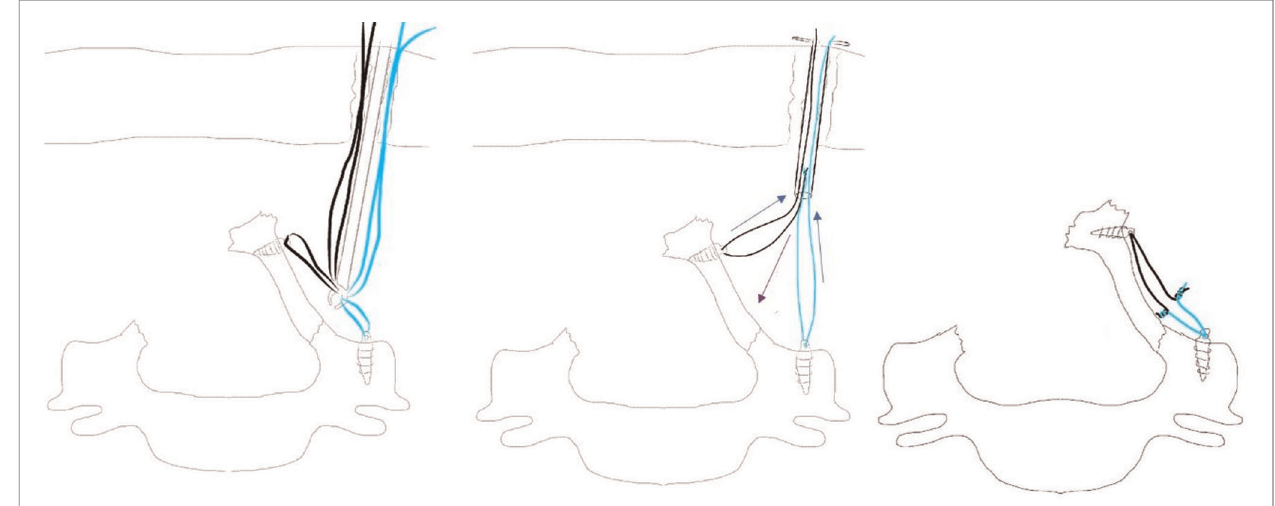
FIGURE 4 | Schematic representation of knotting